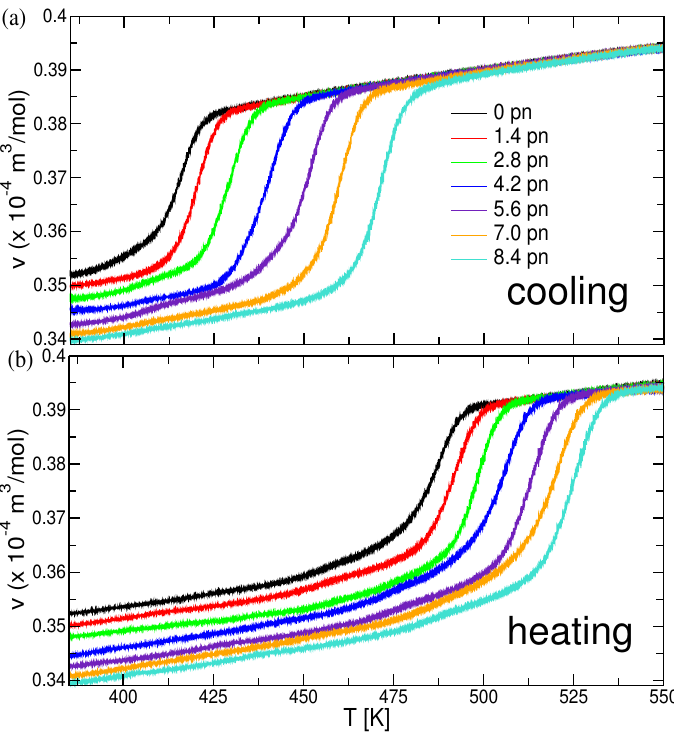
Figure 4. Specific volume as a function of temperature during ( a ) cooling and ( b ) heating cycles. Crystallization and melting temperatures are shown in Figure 5: Systems